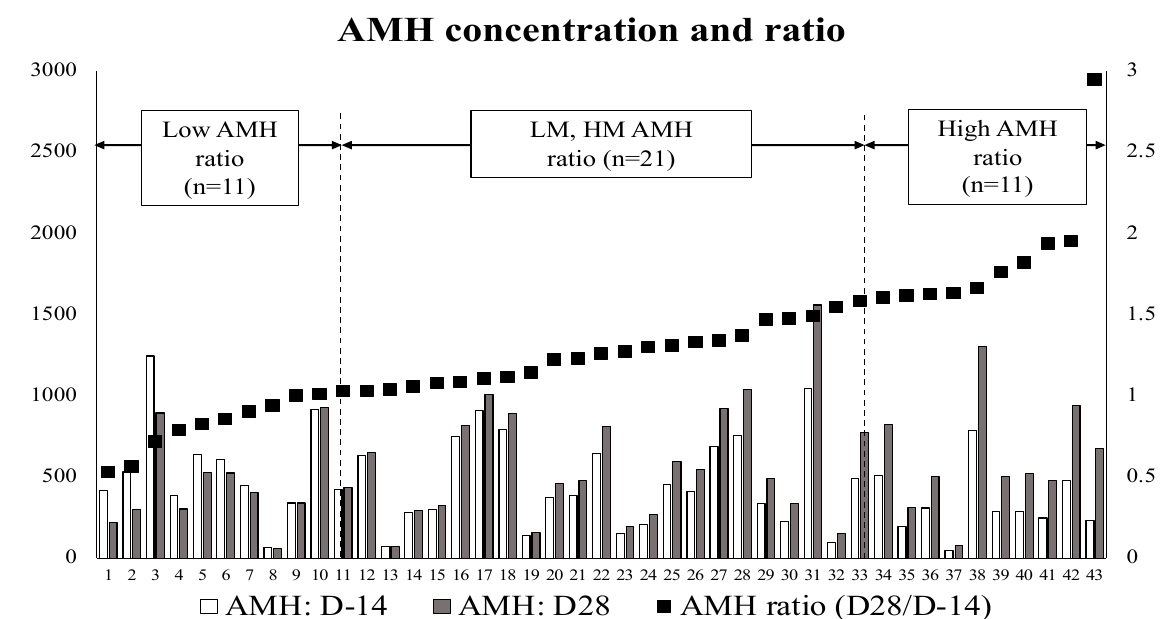
Figure 3. AMH concentration of prepartum (14 days before parturition: D ‐ 14) and postpartum (28 days after parturition: D28) cows, and the AMH ratio (D28/D ‐ 14) of each examined cow ( n = 43). Low ‐ AMH ratio: lowest 25% of cows ( n = 11). LM (low ‐ middle) ‐ and HM (high ‐ middle) ‐ AMH ratios: both comprising 50% of cows ( n = 21). High ‐ AMH ratio: higher 25% of cows ( n = 11). AMH concentrations are depicted as bars and expressed in pg/mL, relative the left ordinate scale. Values of AMH ratio are depicted as points, relative to the right ordinate scale. Table 2. Anti-Müllerian hormone (AMH) concentration (pg/mL) in each classified cow group during pre- and postpartum samplings, and the AMH ratio of each